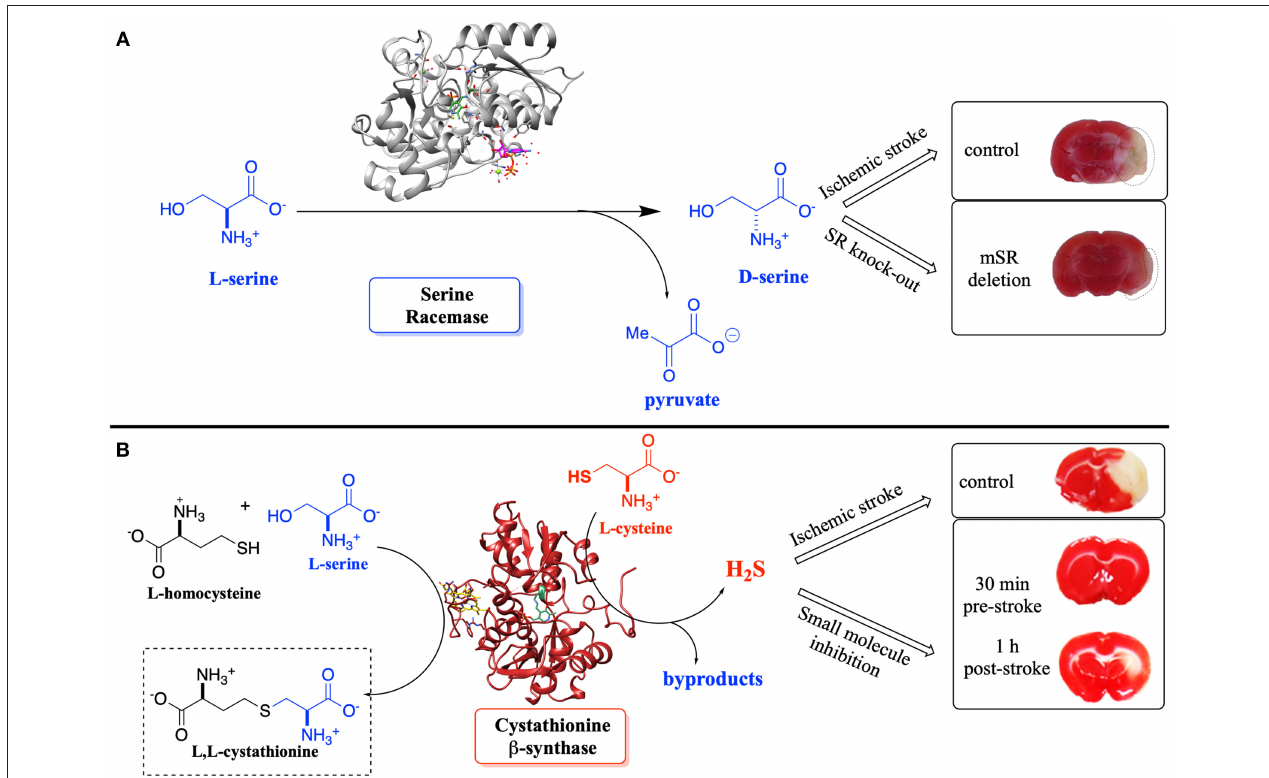
FIGURE 11 | (A) Effect of D-Ser upon infarction volume post-ischemic stroke induced by transient middle cerebral arterial occlusion (tMCAO)–SR-knockout mice vs. control. (B) Effect of H 2 S upon infarction volume–inhibition of CBS vs. control; pre- and post-tMCAO. Adapted from the original articles by permission of the Society for Neuroscience (Mustafa et al., 2010) (image in A ) and the American Chemical Society (Toney, 2005; McCune et al., 2016) (image in B ; https://pubs.acs.org/doi/ abs/10.1021/acscentsci.6b00019), respectively.